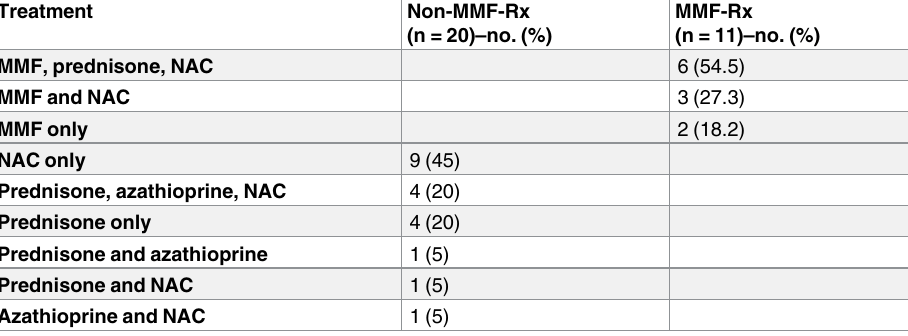
Table 2. Treatment combinations of the MMF-treated and non-MMF-treated